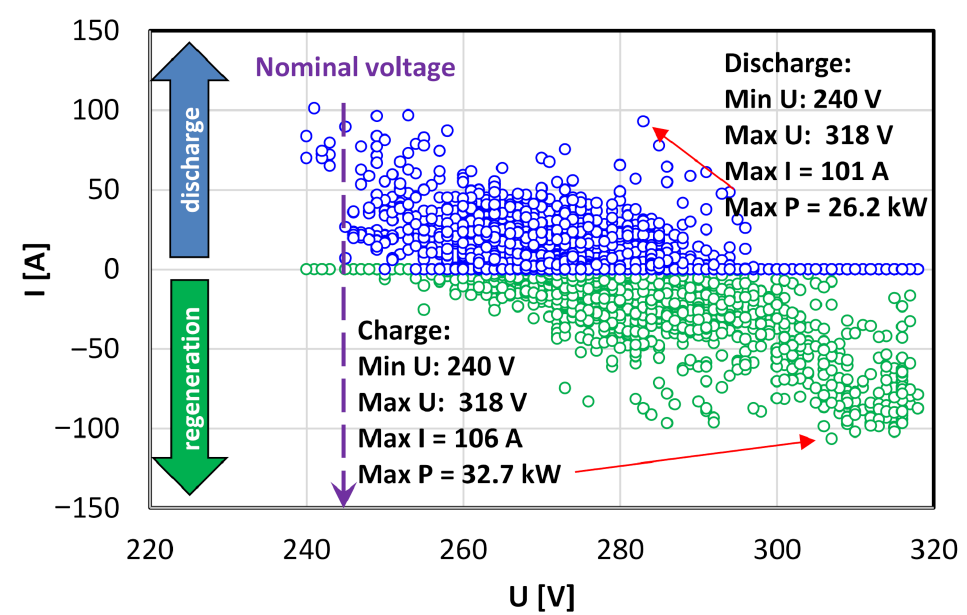
Figure 13. Characteristics of a high voltage battery.